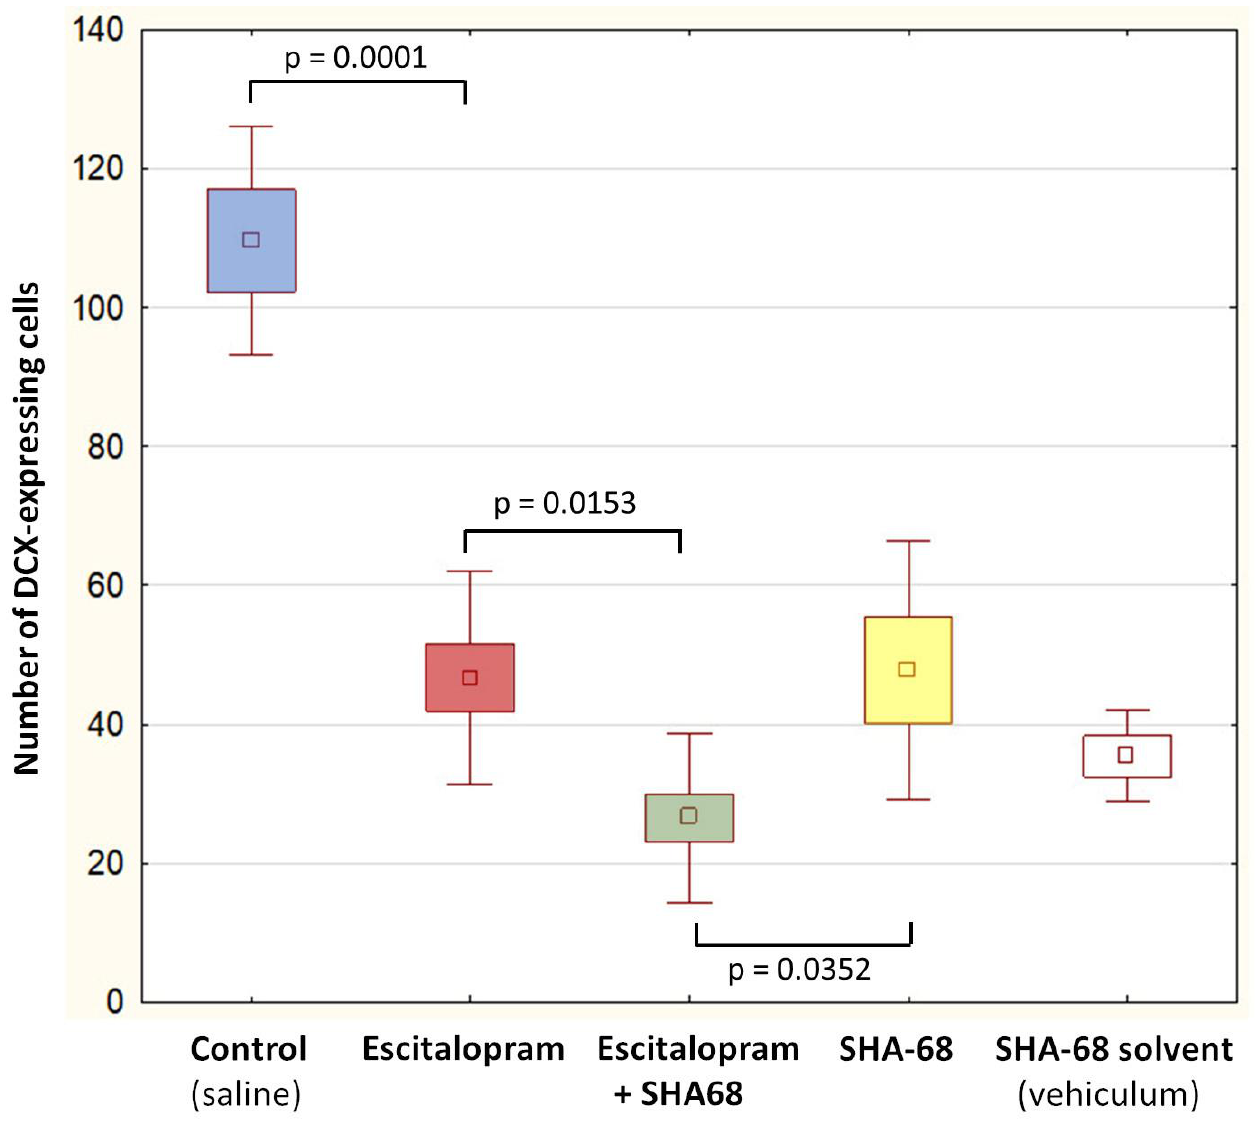
Figure 1. The number of DCX immunopositive cells in the subgranular zone (SGZ). Animals re- ceived: 0.25 mL saline—Control, escitalopram (10 mg/kg)—Esc, escitalopram (10 mg/kg) with SHA-68 (NPSR antagonist, 40 mg/kg)—Esc + SHA-68, only SHA-68 (40 mg/kg), SHA-68 solvent (0.25 mL)—Vehicle, by a single intraperitoneal injection. Boxes show mean SEM and SD, n = 5. Differences between groups were statistically analyzed using ANOVA followed by Tukey’s post hoc test, and they were considered significant at p < 0.05.